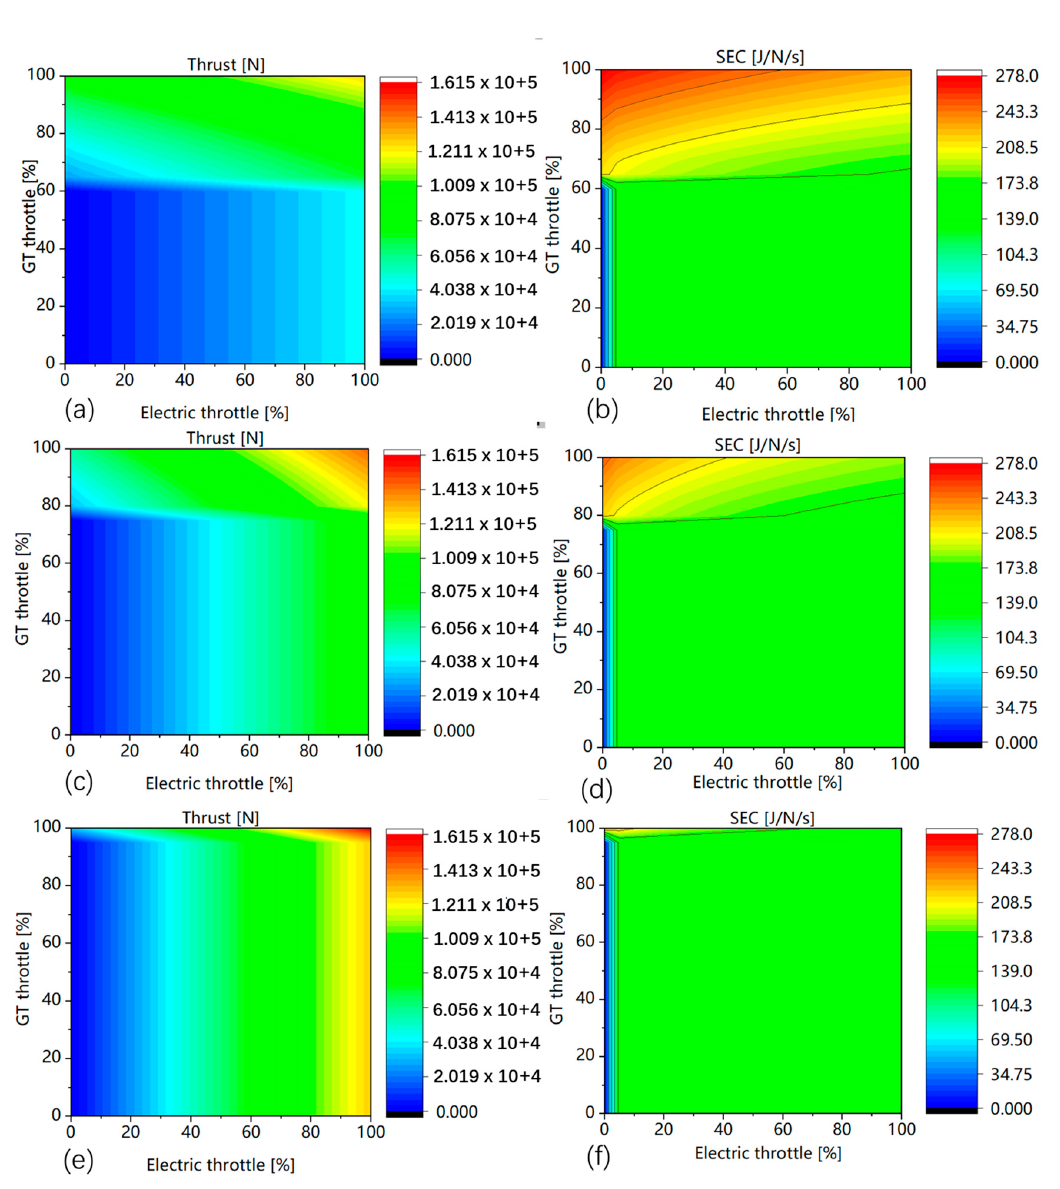
Figure 9. Hybrid-electric thrust and specific energy consumption (SEC) at the static sea level flight condition: ( a , b ) aircraft hybridised by 6 MW EM; ( c , d ) aircraft hybridised by 12 MW EM; ( e , f ) aircraft hybridised by 18 MW EM.